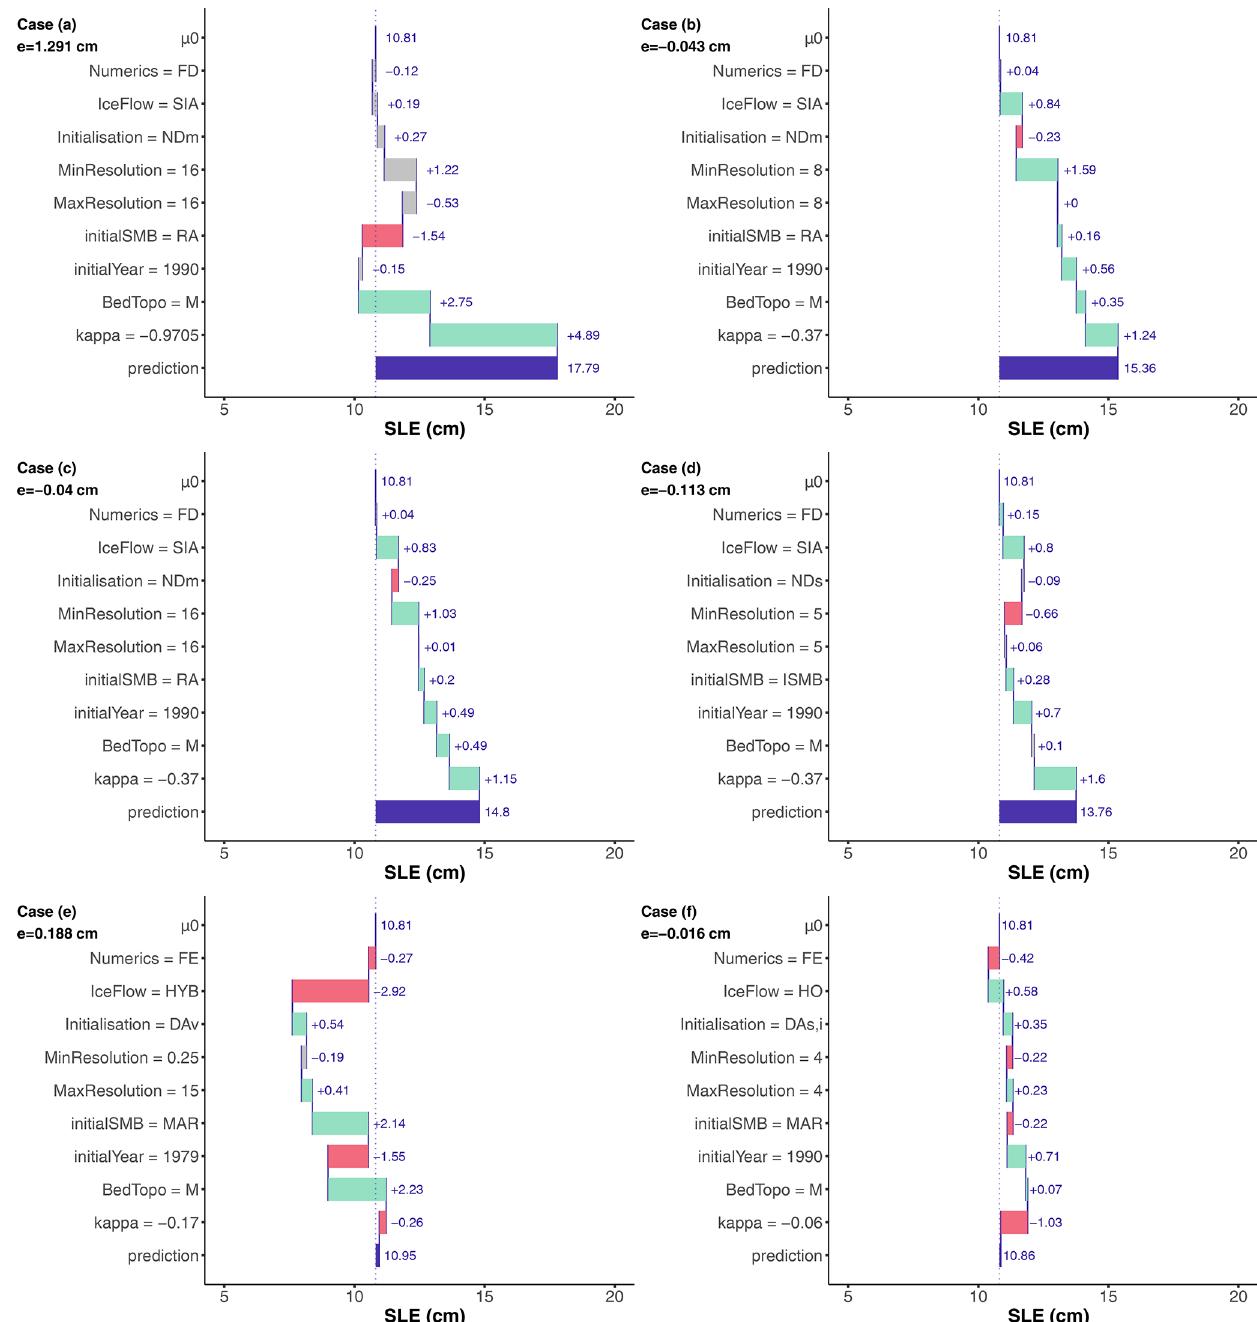
Figure 6. Diagnostic of particular ML-based sl predictions using SHAP for the year 2100 considering six different settings of the modelling choices (indicated on the vertical axis). The horizontal blue bar corresponds to the ML-based sl prediction (the difference with the true value is indicated by the error term e expressed in cmSLE). Each row shows how the positive (green bar) or negative (red bar) contribution of each input moves the prediction from µ 0 , i.e. the unconditional expectation of sl. The grey colour indicates that the contribution cannot be distinguished from the predictive error because its absolute value is below the absolute